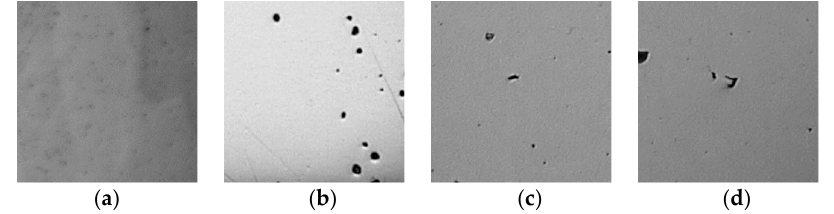
Figure 9. Examples of wrongly classified images in the test dataset of metal additive manufacturing defects. Results highlighted in black and red indicate correct and incorrect classification results, respectively. ( a ) Gas—Good, ( b ) Gas—LoF, ( c ) Gas—LoF, ( d ) LoF—Gas.